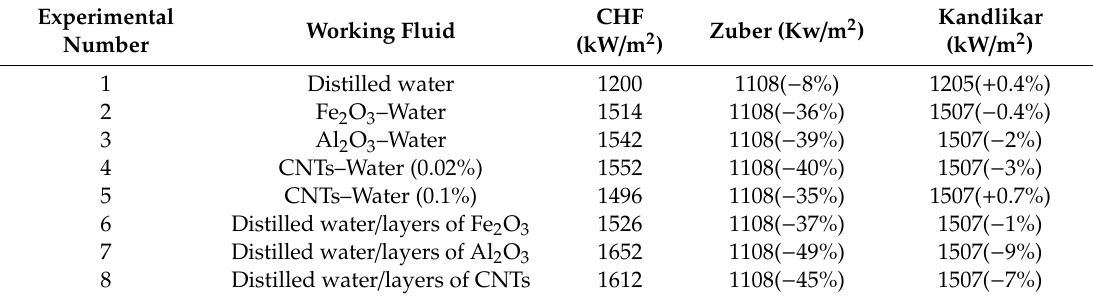
Table 2. Predictions of CHF obtained using Zuber [109] and Kandlikar [110] correlations [76]. Experimental